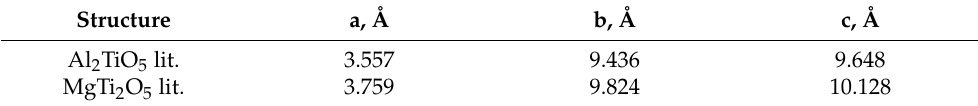
Table 4. Lattice parameters of Al 2 TiO 5 and MgTi 2 O 5 based on the literature data [40,43]. Structure